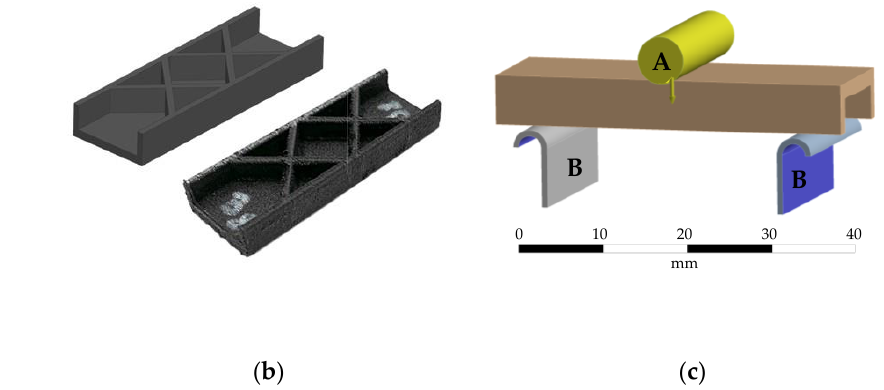
(DIC), whereby the strain on the sample surface is measured by distorting a stochastic grey value pattern, the displacement of the upper fixture as a translation of discrete points. Figure 9. XX-rib specimen geometry: ( a ) Specimen, technical drawing with main dimensions; ( b ) 3D model of and FLM-printed XX-rib specimen; ( c ) Bending load case for XX-rib specimen as applied in FE simulation. All contacts modeled using a coefficient of friction of 𝜇 = 0.3 .